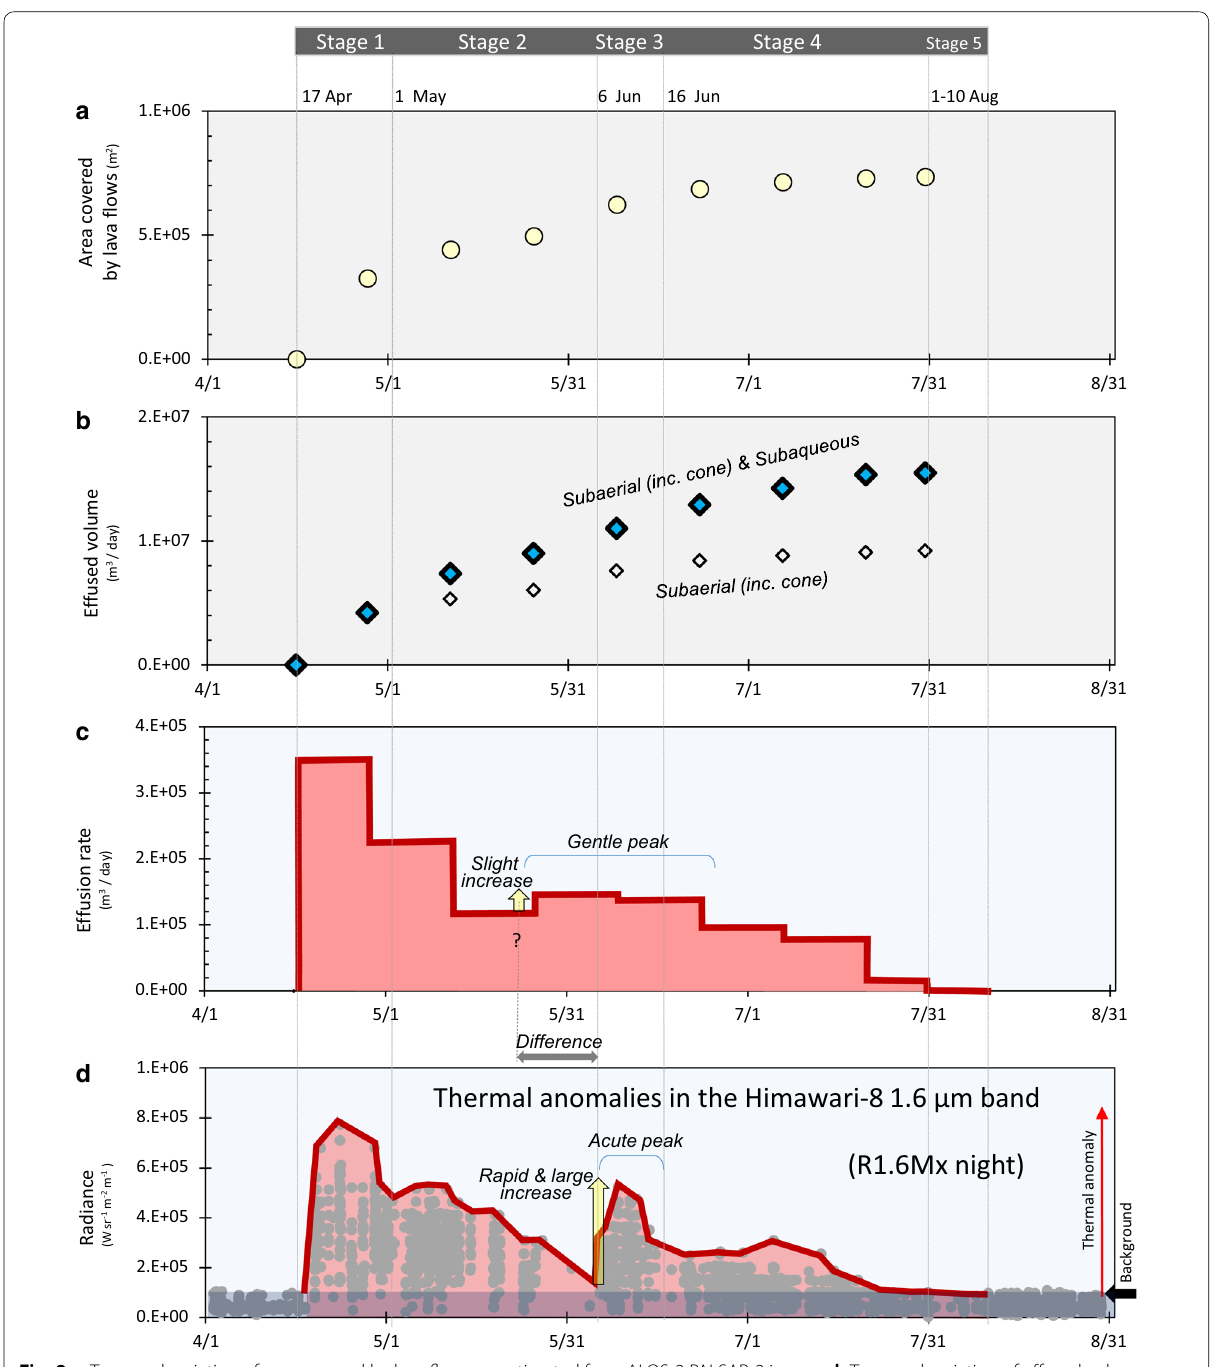
Fig. 8 a Temporal variation of area covered by lava flows, as estimated from ALOS-2 PALSAR-2 images. b Temporal variation of effused volume. c Temporal variation of effusion rate. d Temporal variation of nighttime maximum spectral radiance at 1.6 µm